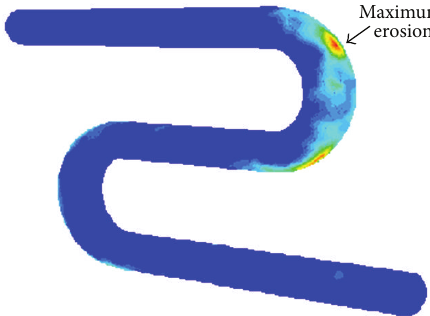
Figure 3: Maximum erosion in S-bend with 𝑟/𝐷 = 1.5